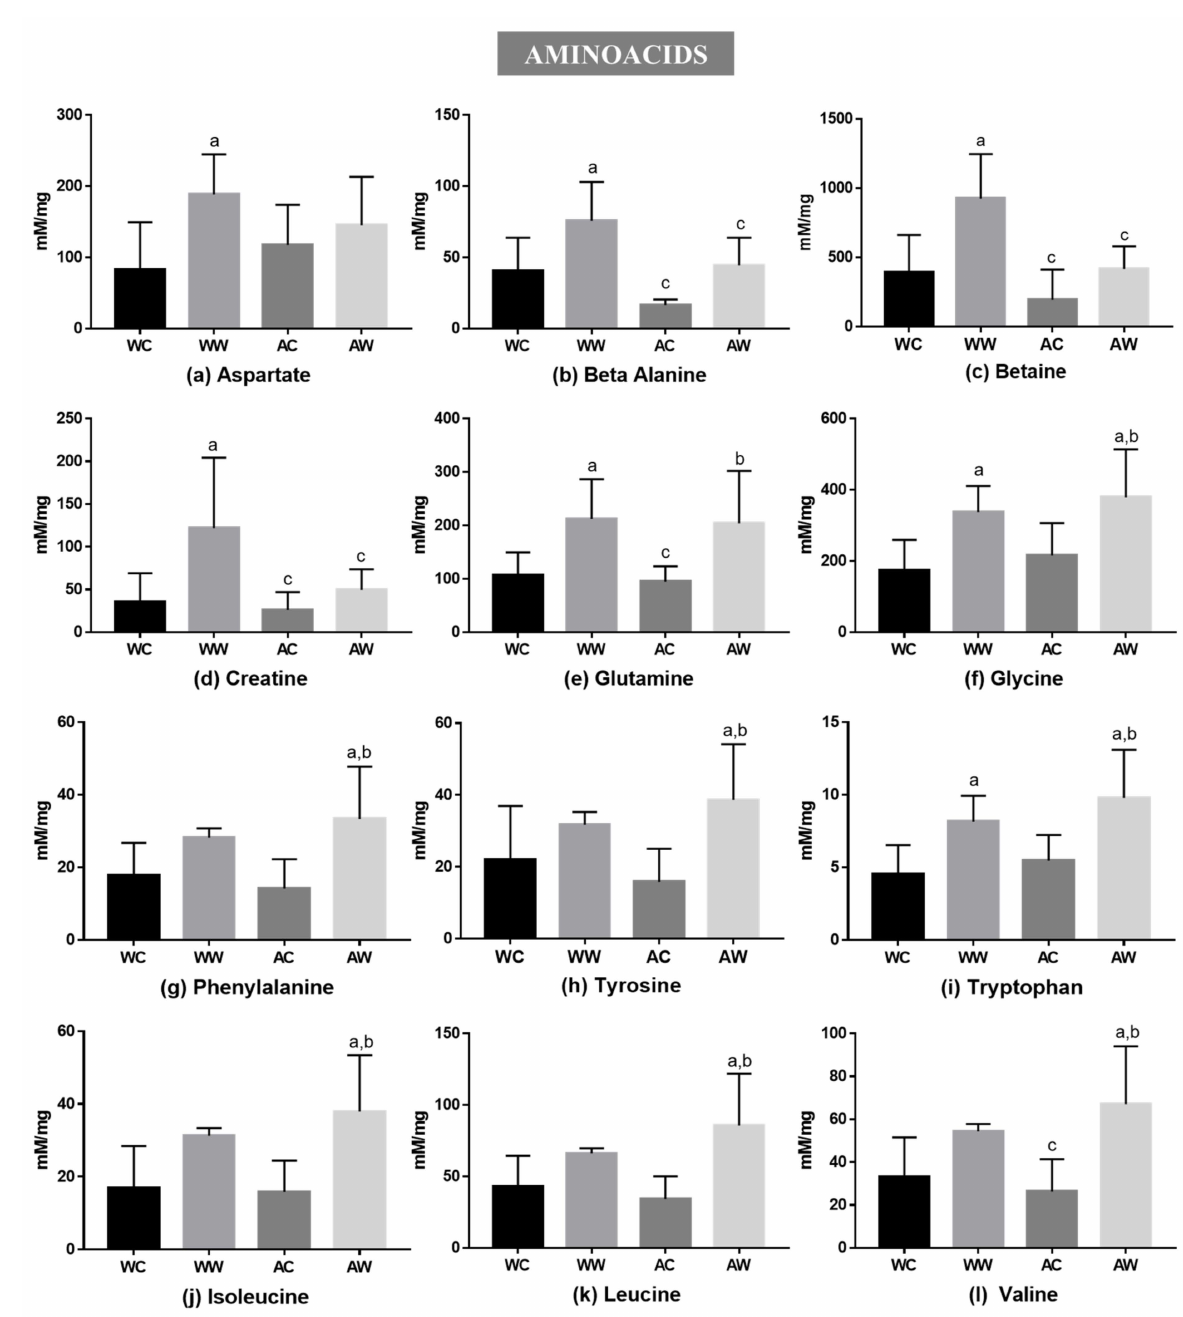
Figure 1. Liver metabolites grouped into amino acids in weanling and adult control and tumour-bearing animals: ( a ) aspar- tate; ( b ) beta-alanine; ( c ) betaine; ( d ) creatine; ( e ) glutamine; ( f ) glycine; ( g ) phenylalanine; ( h ) tyrosine; ( i ) tryptophan and BCAAs: ( j ) leucine; ( k ) leucine; ( l ) valine. Legend: WC, weanling control group ( n = 7); WW, weanling tumour-bearing group ( n = 10); AC, adult control group ( n = 6); AW, adult tumour-bearing group ( n = 8). Data were expressed as mean ± standard deviation (SD), millimolar/milligram of liver tissue. Data were analysed by two-way ANOVA and corrected for multiple comparisons by the post hoc test Bonferroni. a represents differences from the WC group b indicates differences from AC group and c indicates differences from the WW group. Differences were significant when p <